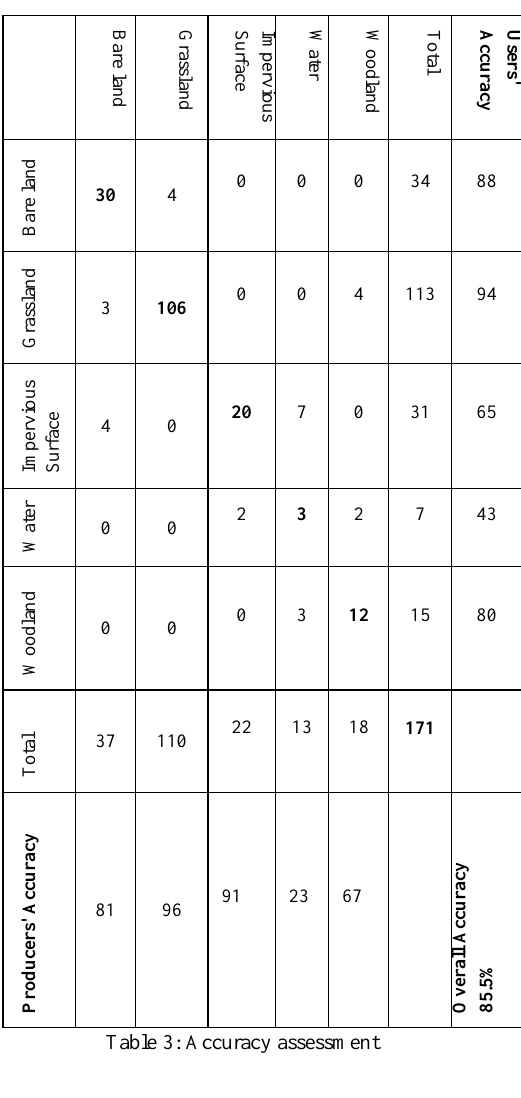
Table 3: Accuracy assessment